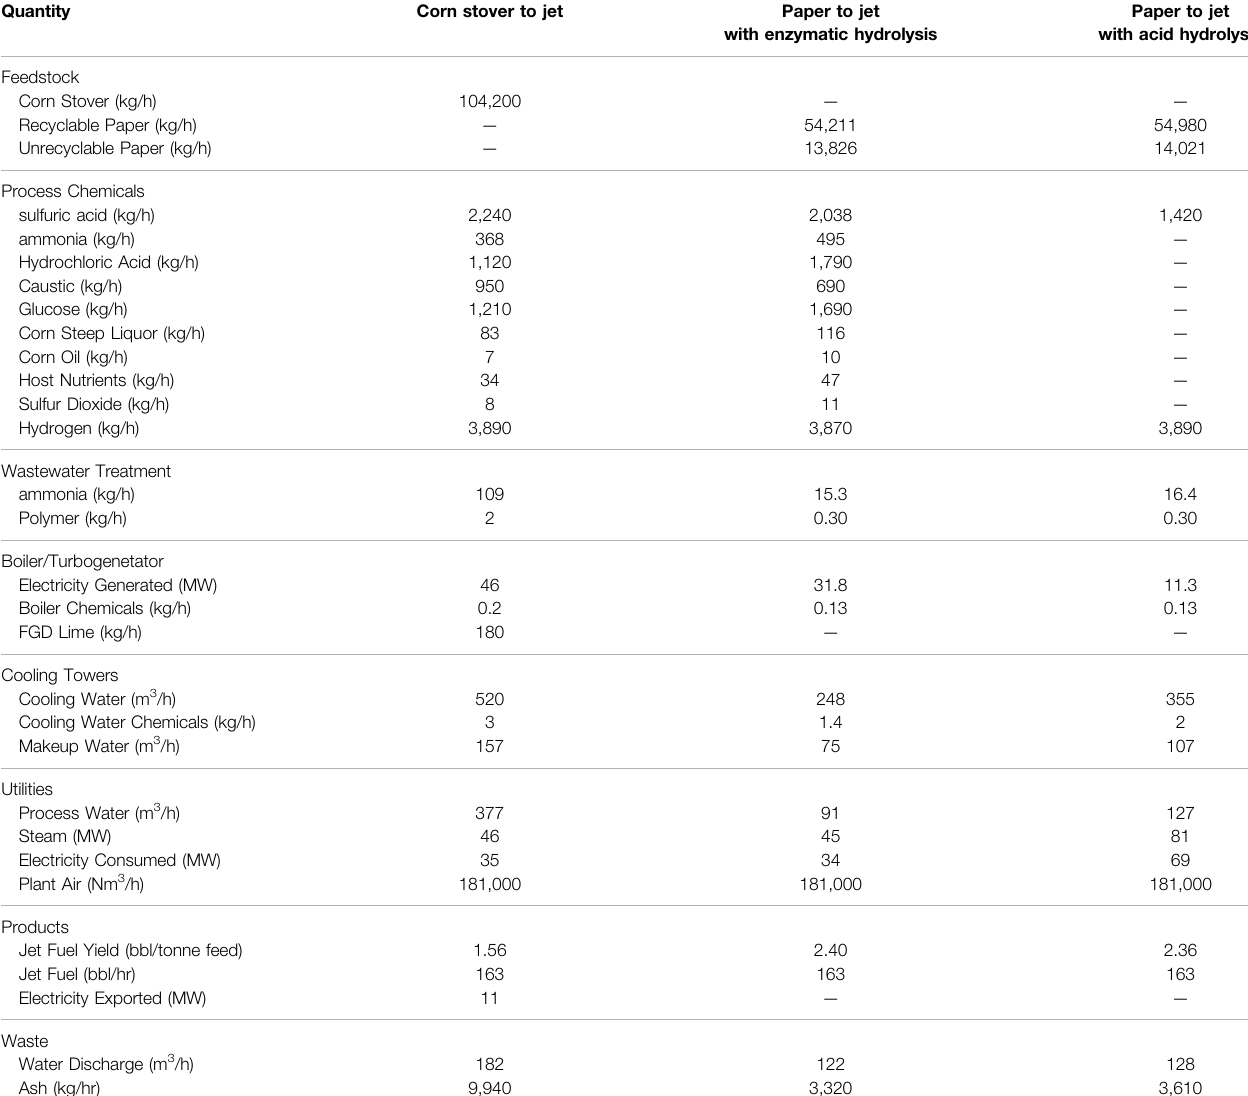
Paper to jet with enzymatic hydrolysis with acid hydrolysis